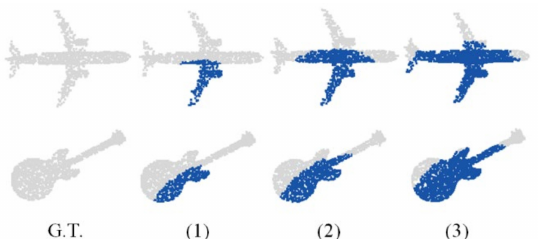
Figure 7. Examples of repairing results when the input has different extents of incomplete data. (1), (2), and (3) lose 25%, 50%, and 75% points of the original point cloud, respectively. Blue represents the prediction. Gray denotes the undamaged point cloud. Table 2. Pred → GT/GT → Pred error of the missing point cloud obtained using the PP-Net.